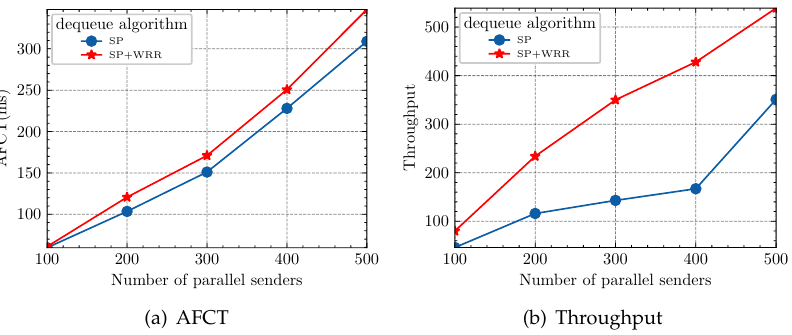
Figure 3. Incast environment: the impact of different dequeue method thresholds on short-flow AFCT and long-flow